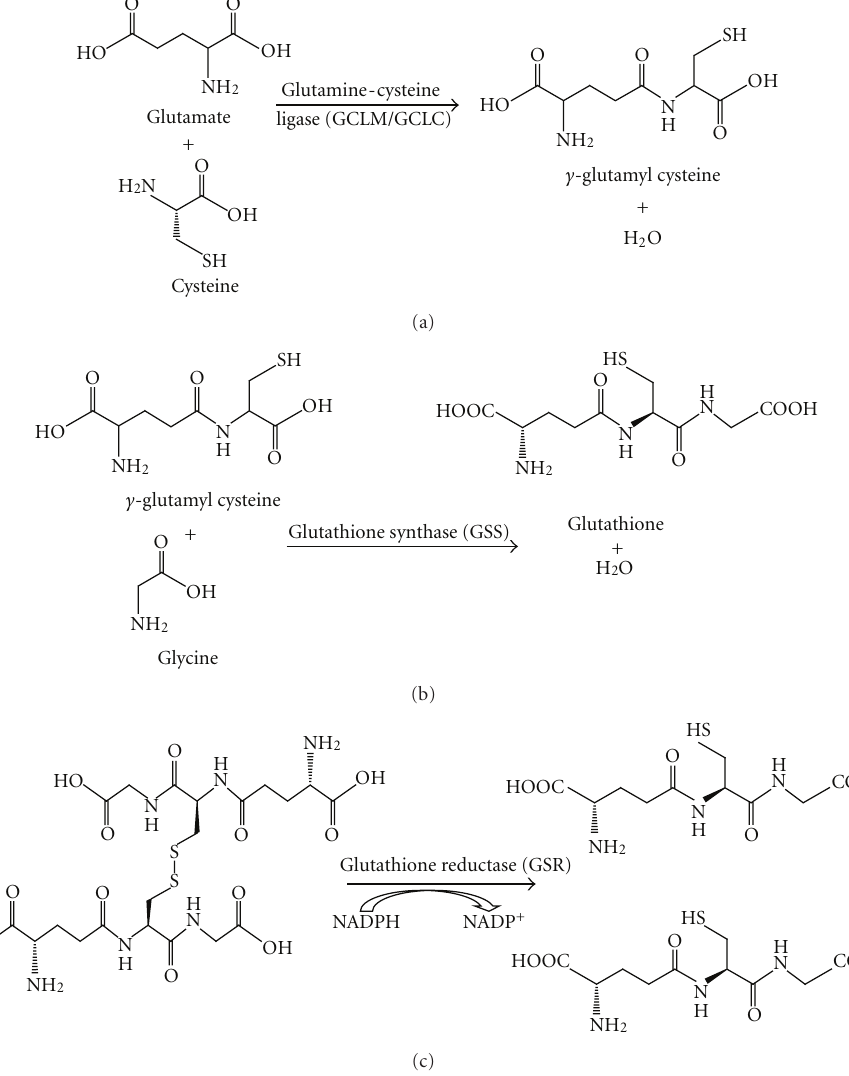
Figure 1: (a) The first step in de novo GSH biosynthesis is rate limiting. Glutamine and cysteine are linked by the homodimeric enzyme glutamine-cysteine ligase, (b) GSS catalyzes the second step in GSH biosynthesis, linking glycine and γ -glutamyl cysteine to form GSH. (c) Oxidized GSH can be converted to free GSH by GSR, utilizing NADPH as a cofactor.